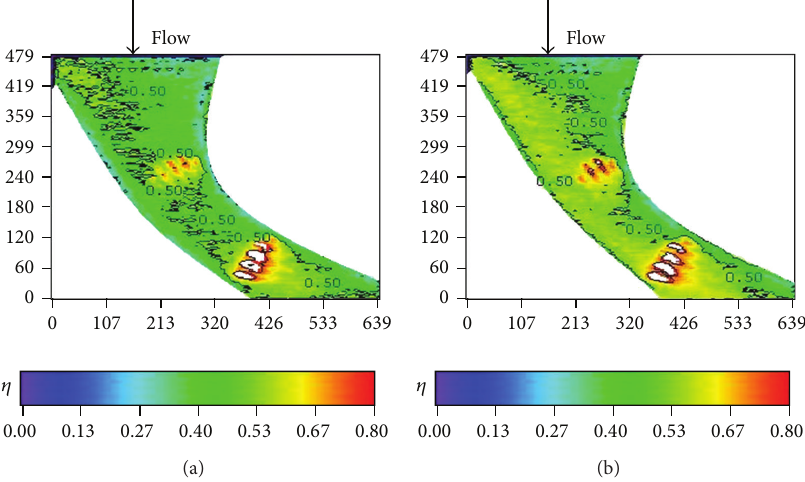
Figure 14: Effectiveness distributions on stepped endwall at high turbulence intensity (Re = 124000 , 𝑀 = 1 , and T . I . = 12 %). (a) 𝑆/𝐶 = 4 %. (b) 𝑆/𝐶 = −4 %.